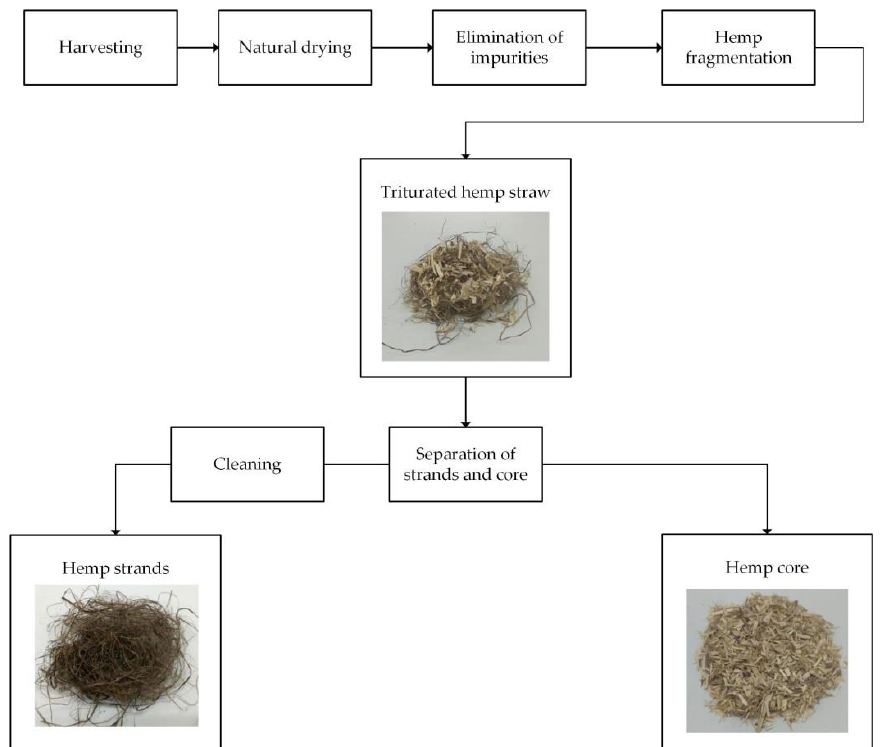
Figure 1. Process used to obtain hemp fibers.